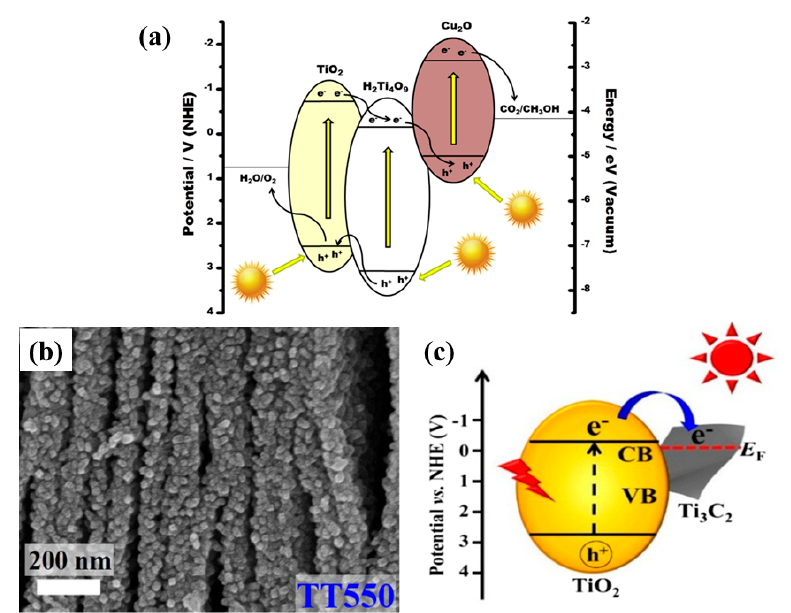
Figure 10. ( a ) Schematic view of the band energy diagram for Cu 2 O-loaded TiO 2 pillared photocatalysts for conversion of CO 2 into value-added chemicals (taken with permission from [68]). ( b ) FESEM image for TT550 sample displaying the layered structure of MXenes loaded with TiO 2 nanoparticles, and ( c ) the proposed mechanism of photogenerated charge transfer within the TiO 2 -Ti 3 C 2 2-D nanostructure (taken with permission from [69]).